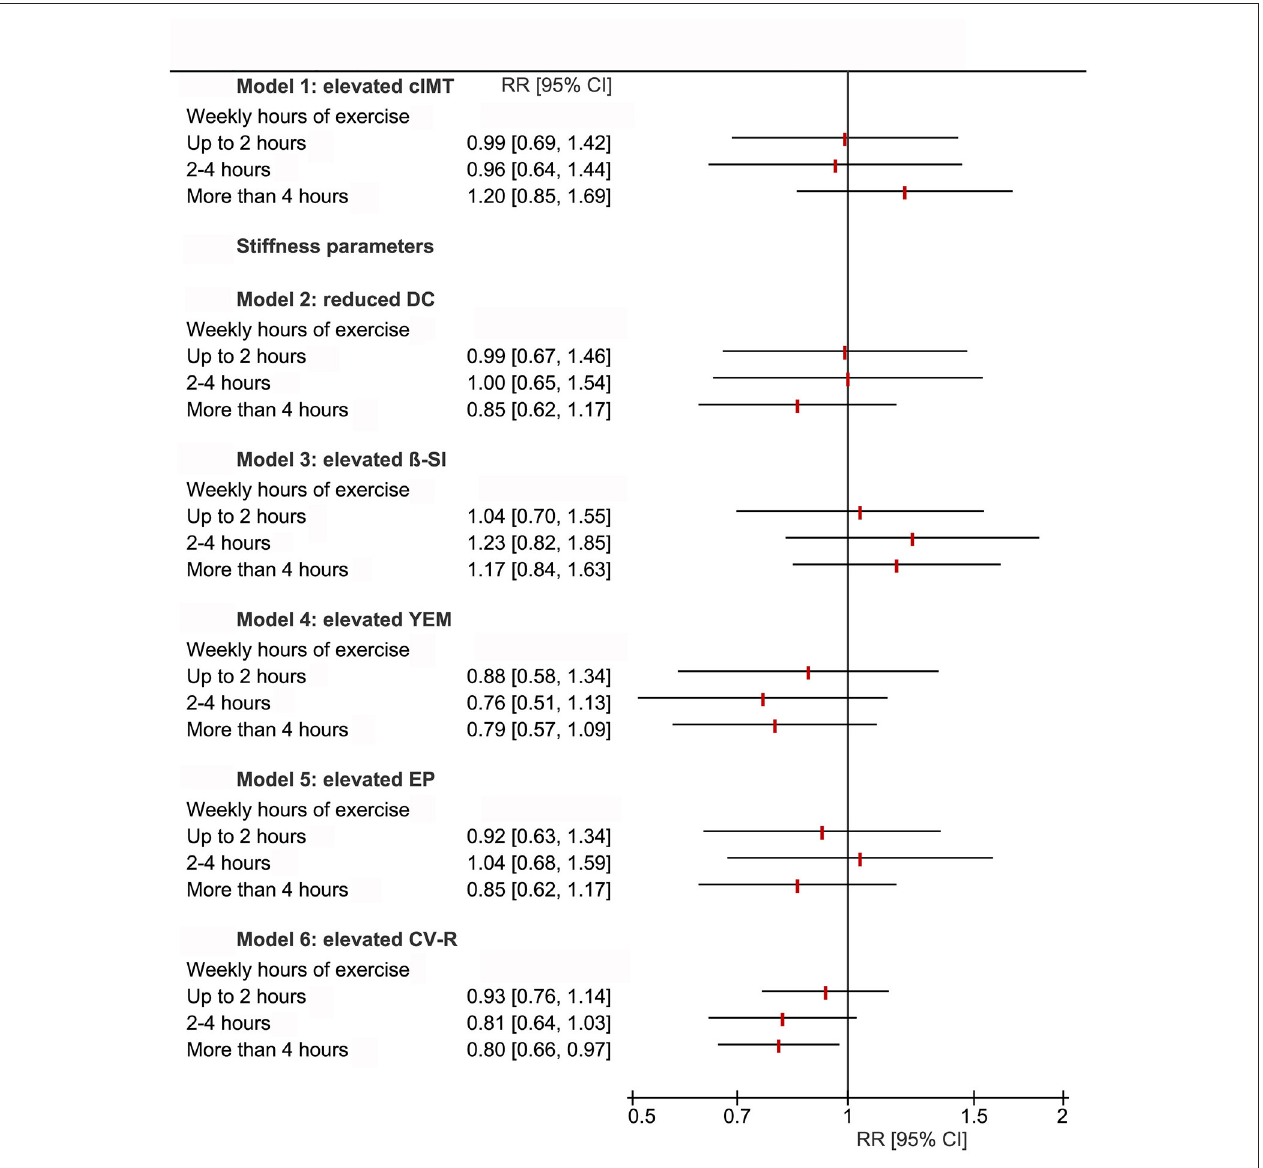
FIGURE 3 | Forest plot demonstrating relative risk for intima-media thickness (cIMT ≥ 90th percentile), parameters of carotid stiffness (cS ≥ 90th percentile) and elevated cardiovascular risk (CV-R ≥ 1 standard deviation) stratified by cross-sectional exercise at KiGGS-Wave-2. Relative risk for elevated CV-R is significantly lower with higher volumes of cross-sectional exercise. No between-group differences were observed for relative risk of elevated cS parameters and cIMT. Results from log binomial regression models. If the 95% confidence interval does not include the null value (RR = 1), the finding is statistically significant. Reference level of exposure: no regular exercise; weighted analyses. DC, distensibility coefficient; β -SI, ß stiffness index; YEM, Young’s elastic modulus; EP, Peterson’s elastic modulus; CV-R, Index of cardiovascular risk (sum of z -scores of mean arterial pressure, triglycerides, total/HDL-cholesterol-ratio, body mass index, and HbA1c); RR [95%-CI], Relative risk [95%–confidence